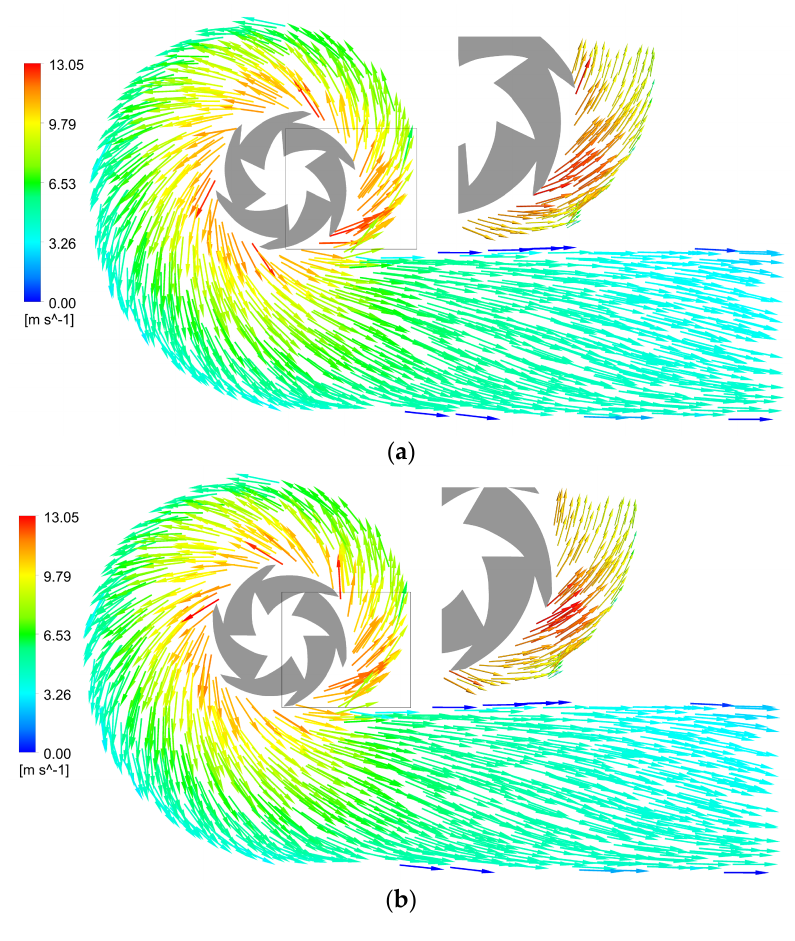
Figure 11. Velocity vector distribution at the point of 1.0 Q des with different phase positions: ( a ) 0°; ( b ) 30°.